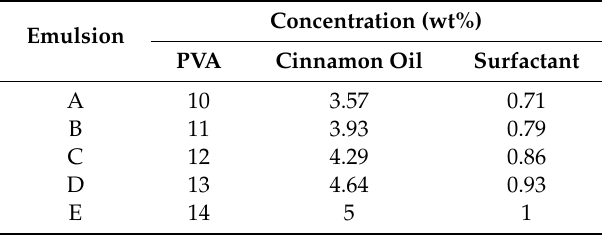
Table 1. Cinnamon oil / PVA emulsion concentrations for imparting antimicrobial activity.